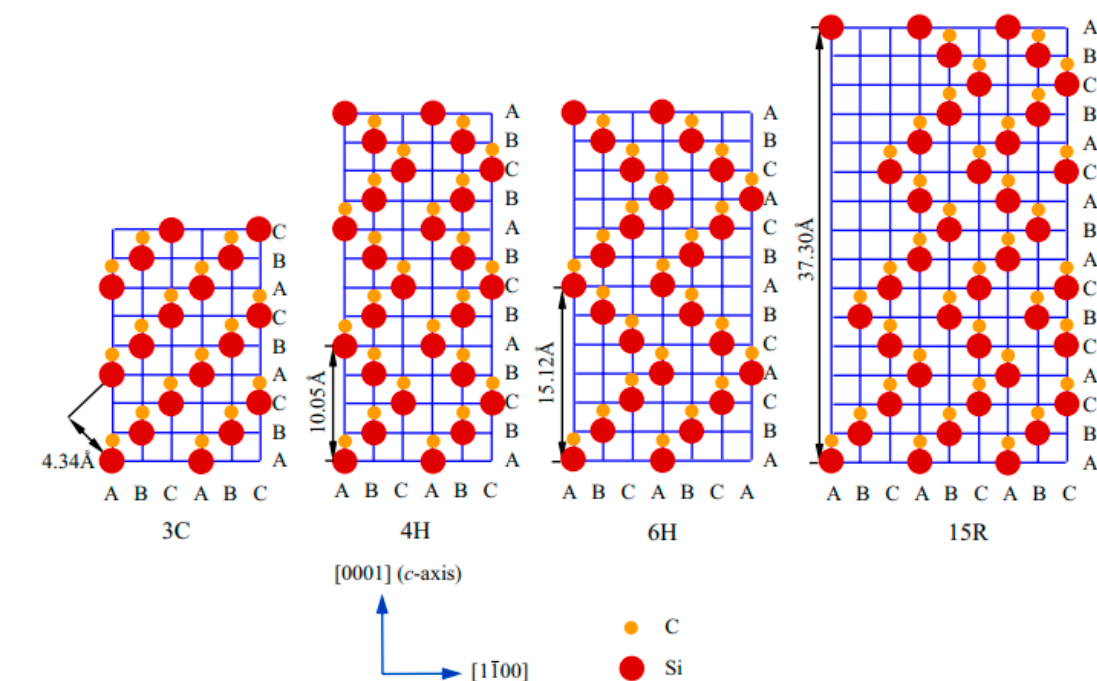
Figure 1. Stacking sequences of layered 3C-, 4H-, 6H-, and 15R-SiC [50].